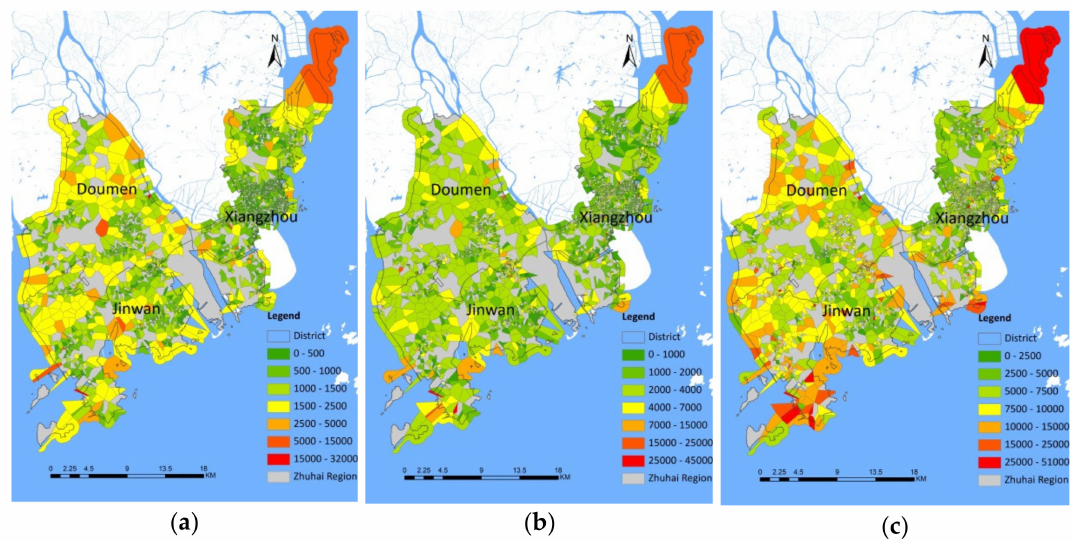
Figure 5. The radius of activity space in the mobile phone tower service areas. ( a ) Maintenance activity space; ( b ) Commuting activity space; ( c ) Recreational activity